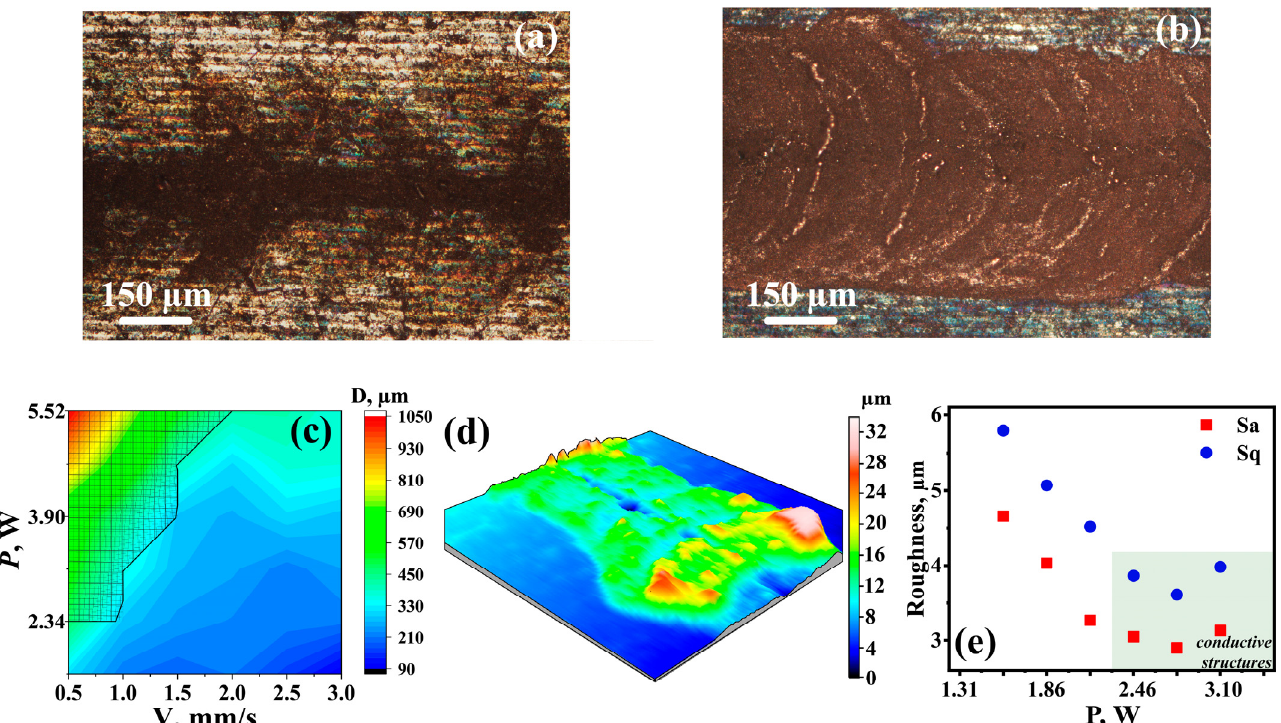
Figure 3. Morphology of copper tracks deposited ( a ) without and ( b ) with an auxiliary glass substrate; ( c ) processing regime diagram depending on the processing parameters, where D is the width of the structure. The area of the conductive structure’s acquisition. ( d ) Profilometry of a characteristic, electrically conductive structure. Laser parameters: P = 3.1 W, V = 0.5 mm/s, f = 20 kHz, and τ = 200 ns. ( e ) Surface roughness of structure depending on the laser power at V = 0.5 mm/s, f = 20 kHz, and τ = 200 ns.